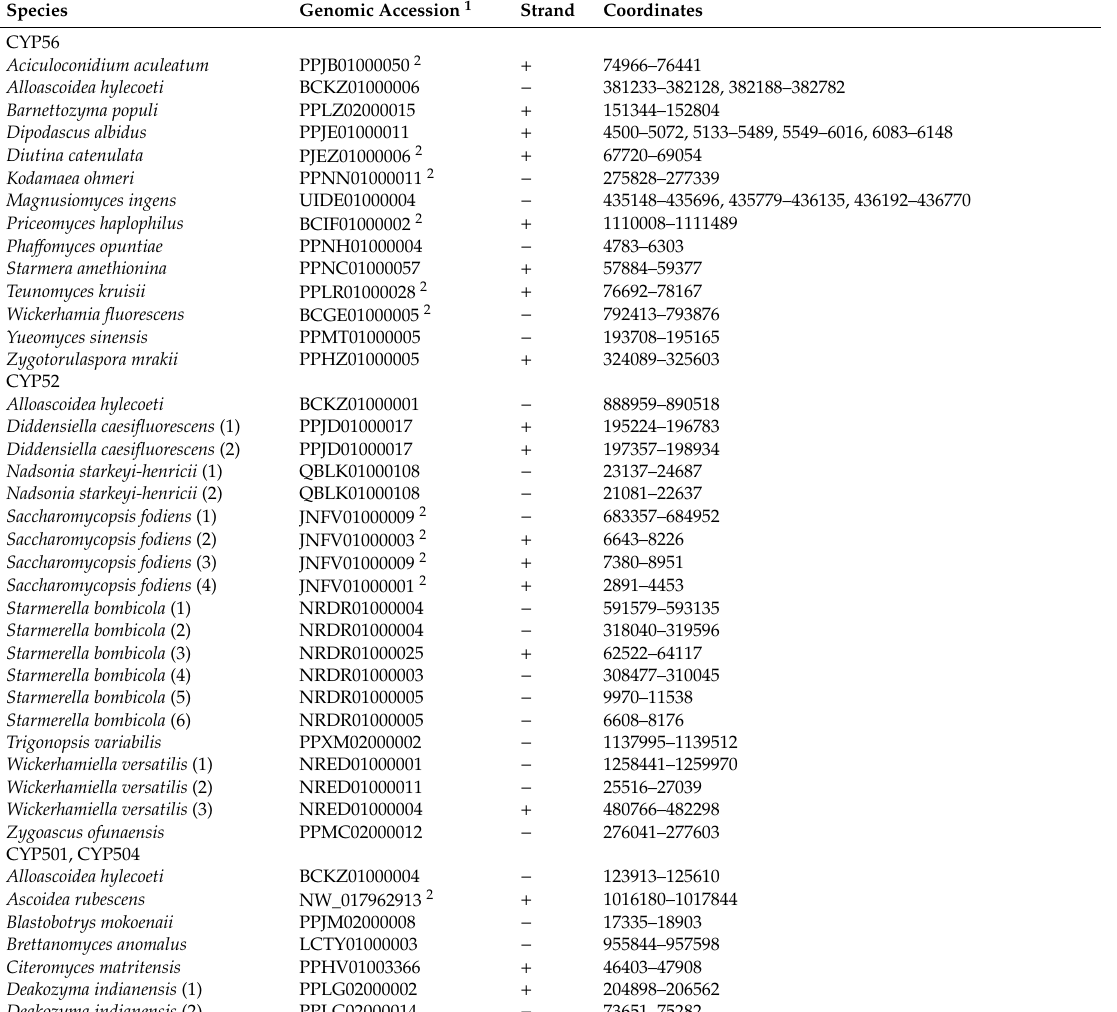
Table A1. Genomic sequences used for conceptual translation into protein sequences for phylogenetic analysis. Numbers in parentheses refers to numbered sequences in the corresponding figures. Species